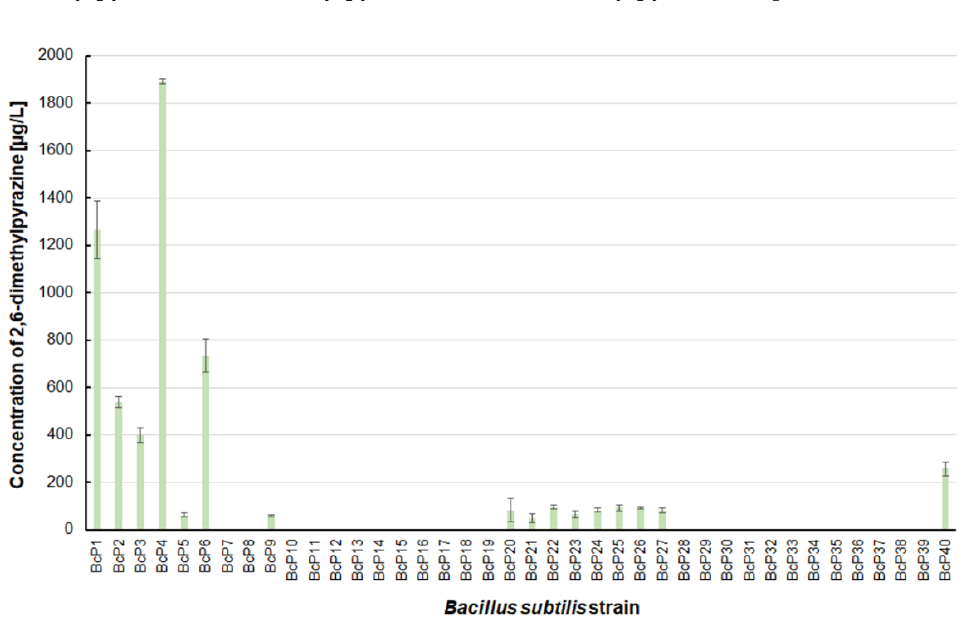
Figure 4. The 2,3-dimethylpyrazine biosynthesis by B. subtilis strains. The findings for 2,6-dimethylpyrazine were comparable to those for 2-methylpyra- zine (Figures 3 and 5). The BcP4 strain was also the most effective producer of 2,6-dime- thylpyrazine, but the obtained concentration was much higher, nearly 1900 µg/L. The sec- ond-best producer of this compound is also the BcP1 strain, which produced 2,6-dime- thylpyrazine at 1265.2 ± 121.2 µg/L (Figure 5). Among the isolated strains of B. subtilis that produced pyrazines at concentrations of µg/L, the BcP4 strain was the most effective pro- ducer of 2-methylpyrazine, 2,3-dimethylpyrazine and 2,6-dimethylpyrazine (Figures 3 – 5).